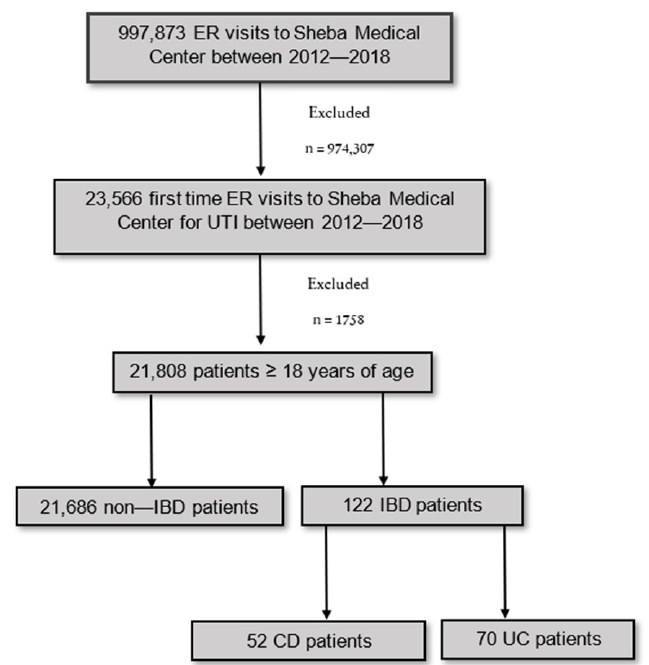
Figure 1. Study flow chart. Abbreviations: ER, emergency room; UTI, urinary tract infection; IBD, inflammatory bowel disease; CD, Crohn’s disease; UC, ulcerative colitis. The baseline characteristics of patients with and without IBD are presented in Table